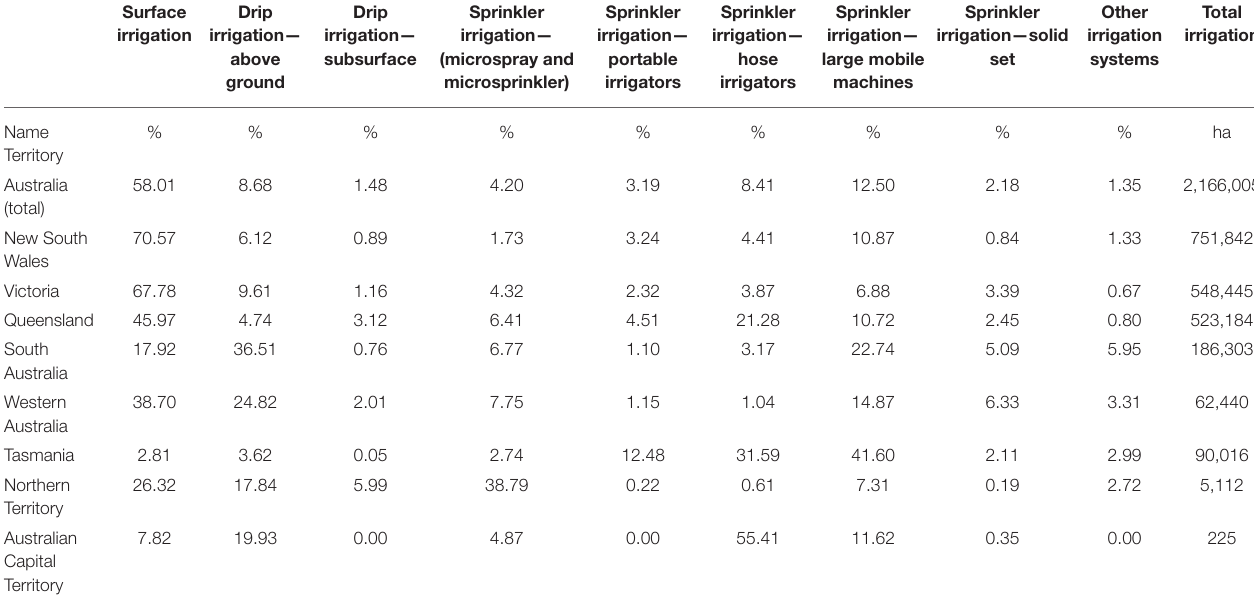
TABLE 5 | Average fraction of area irrigated with different type of systems. Surface Drip Drip irrigation irrigation— above ground